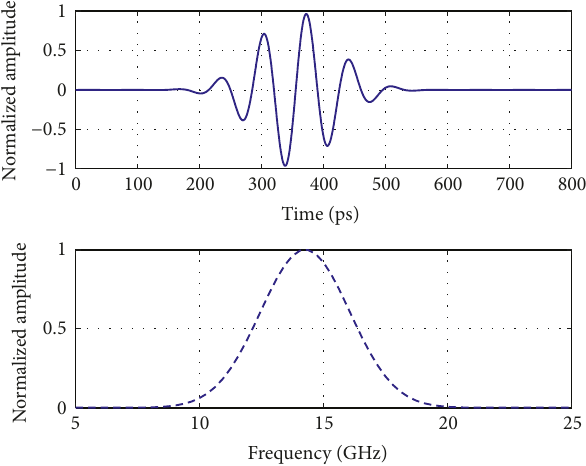
Figure 7: Signal excitation in time and frequency